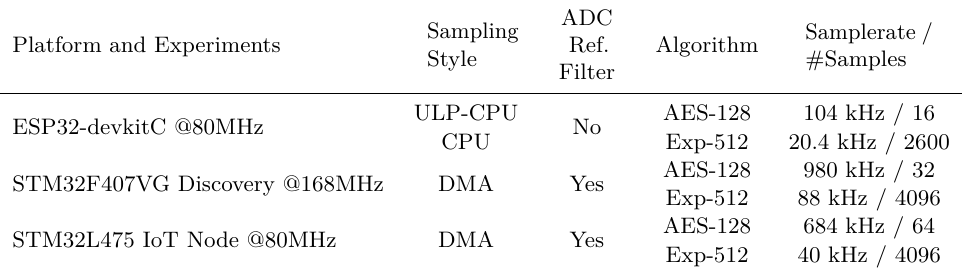
Table 2: Overview of Leakage Assessment Experiments, repeated for ADC Pin = { Vdd, GND, N/C } Platform and